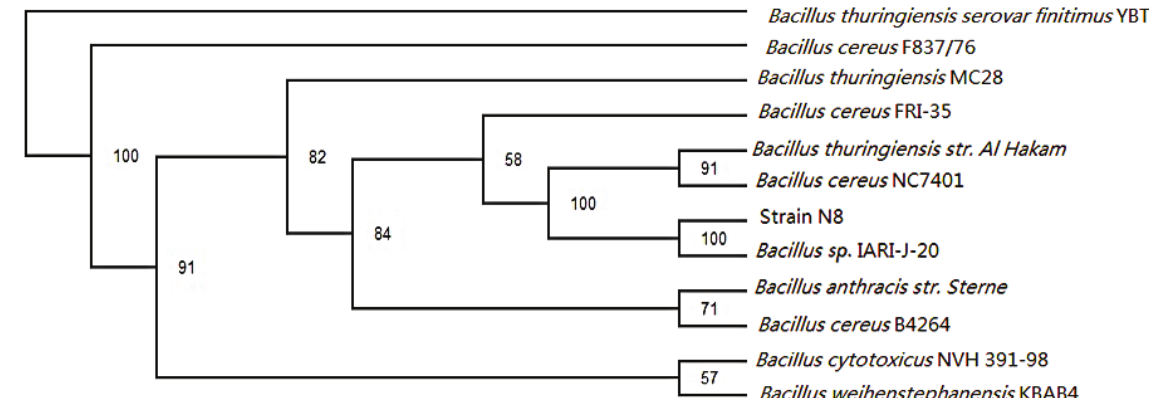
Fig. 2 – Phylogenetic tree of strain